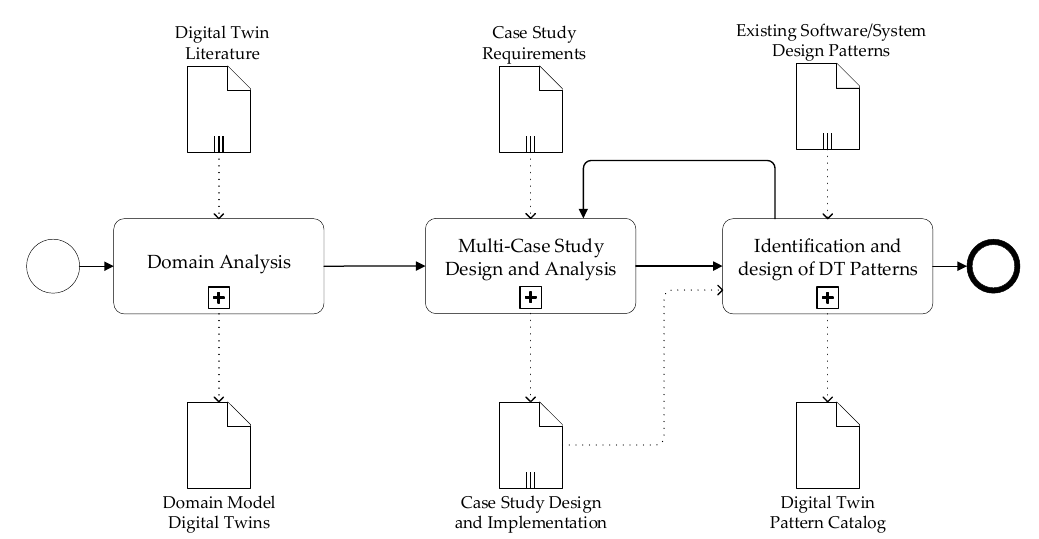
Figure 3. Adopted research methodology.